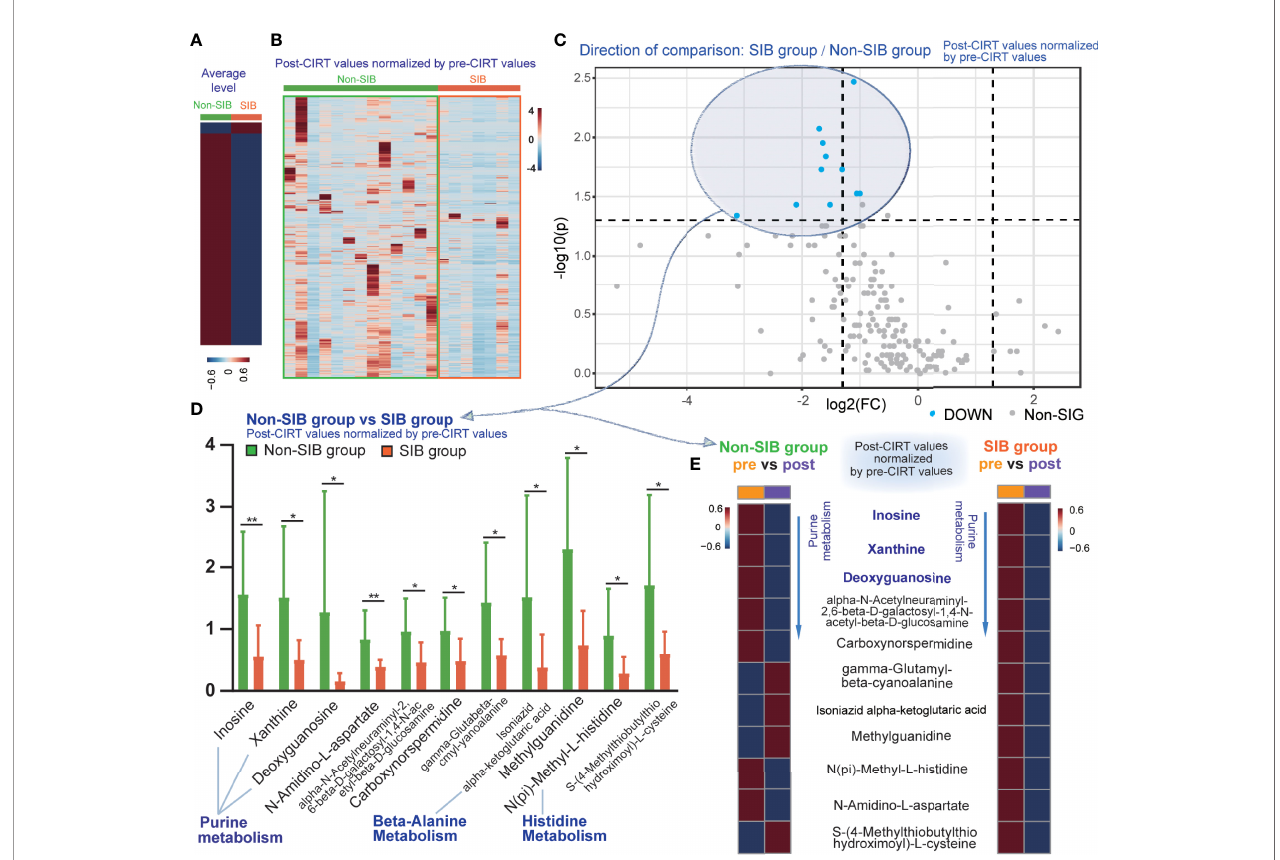
FIGURE 5 | The inhibition effect of the SIB CIRT technique on PCa metabolism compared to uniform-dose-distribution CIRT. The heat map compared the average (A) and detailed (B) level of post-CIRT values normalized by pre-CIRT values between the two groups. (C) The volcano plot of the normalized post-CIRT values of the SIB group and the non-SIB group. Blue dots represented metabolites that had signi fi cantly lower concentrations in the SIB group compared with the non-SIB group. (p<0.05, FC>2) (D) Box plots of 11 identi fi ed signi fi cantly discriminative metabolites between the SIB group and the non-SIB group. (E) The heat map showed the average level of pre-CIRT samples and post-CIRT to compare the variation of these signi fi cantly discriminative metabolites in both groups,